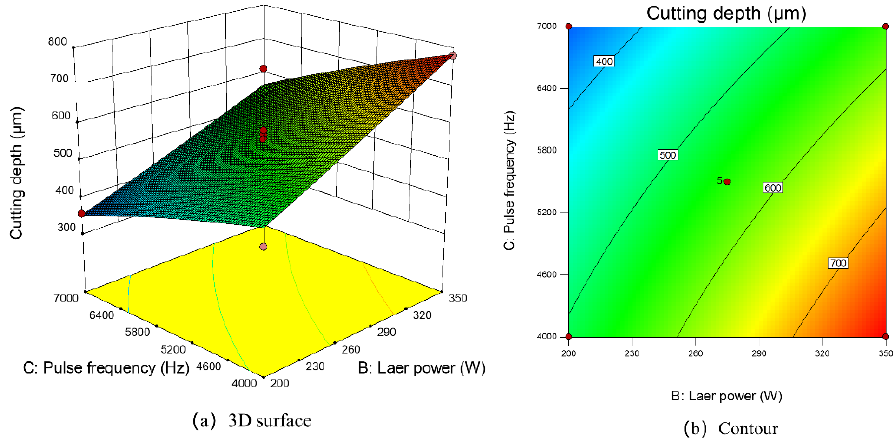
Figure 15. The 3D surface and contour map of the influence of laser power and pulse frequency on cutting depth.